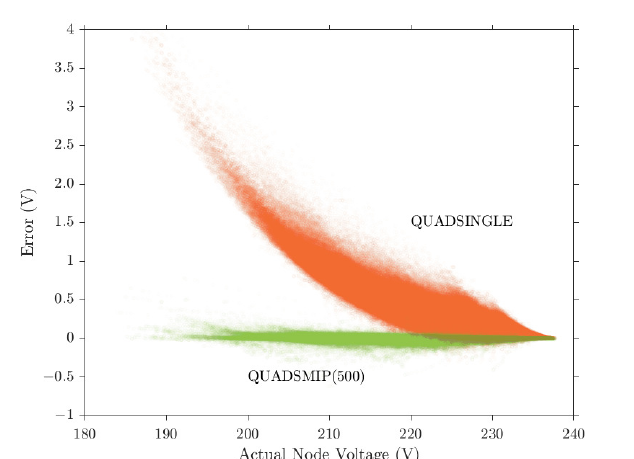
Figure 2. Distribution of node voltage error, which shows the improvement of the SMIP in the quadratic Taylor series